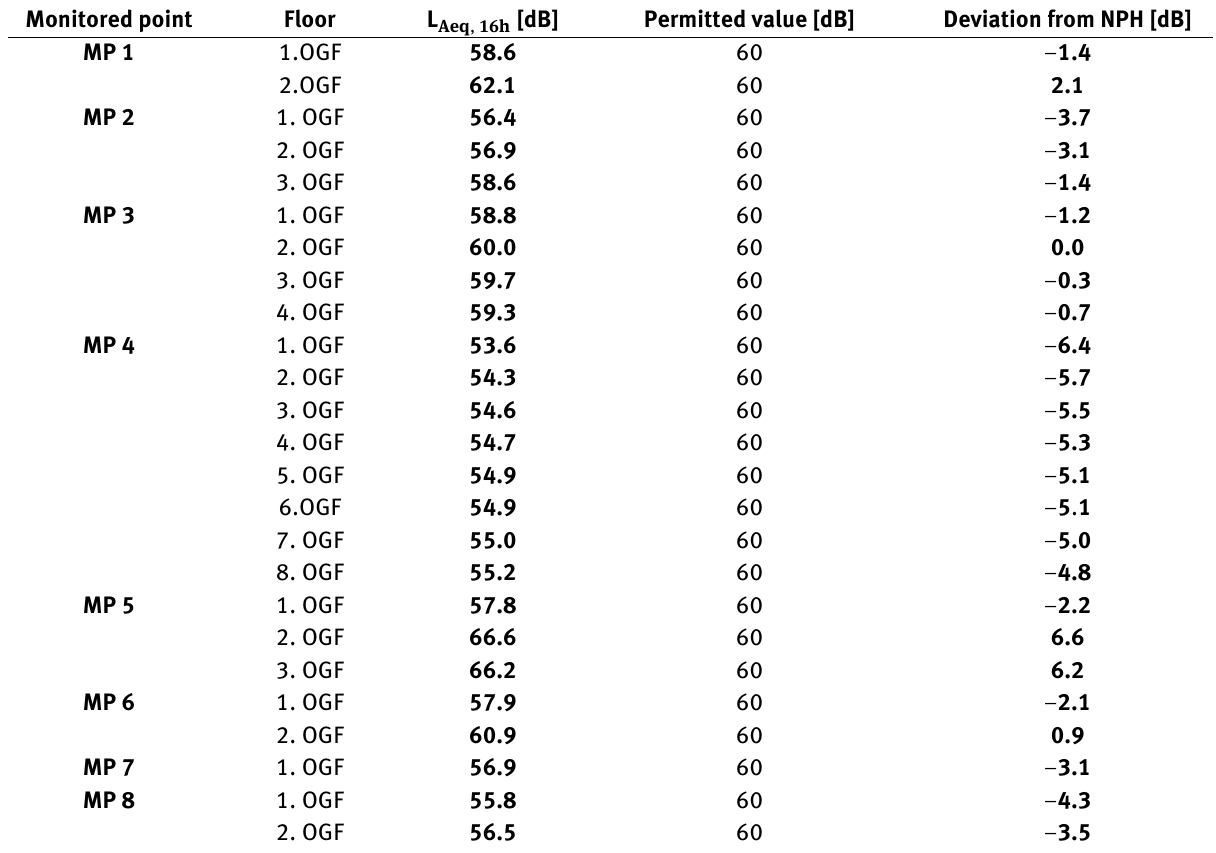
Table 5: Calculated levels for a variant with the construction of a bypass - reference time interval – day Monitored